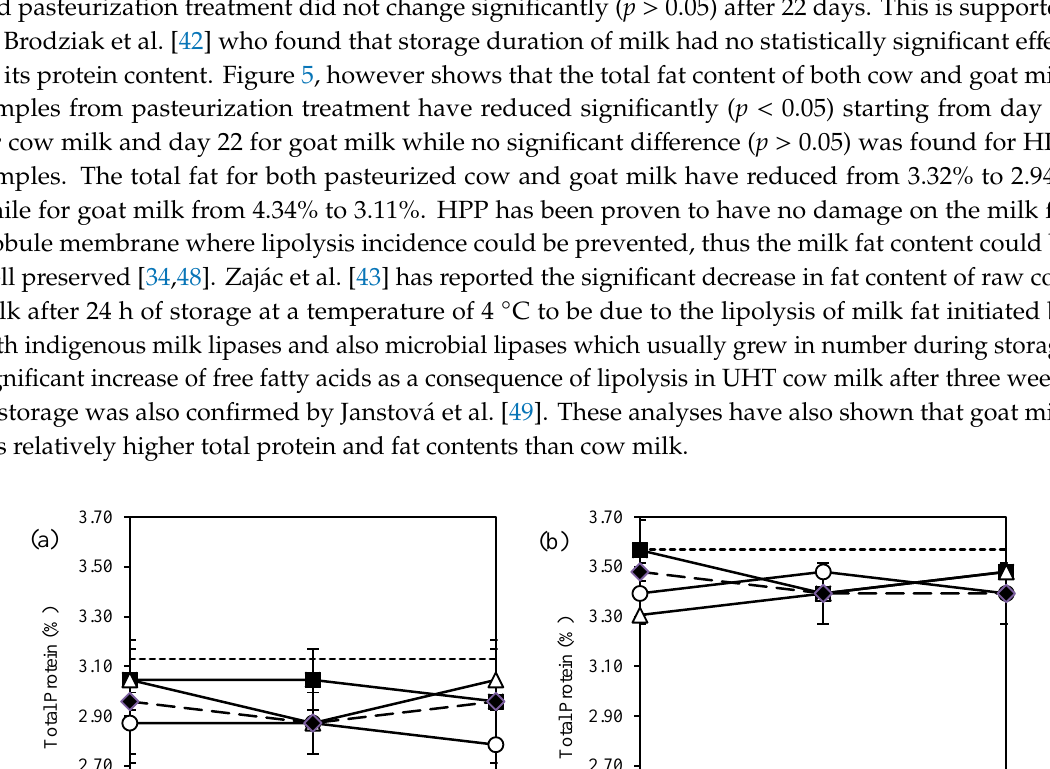
2.502.702.903.103.30